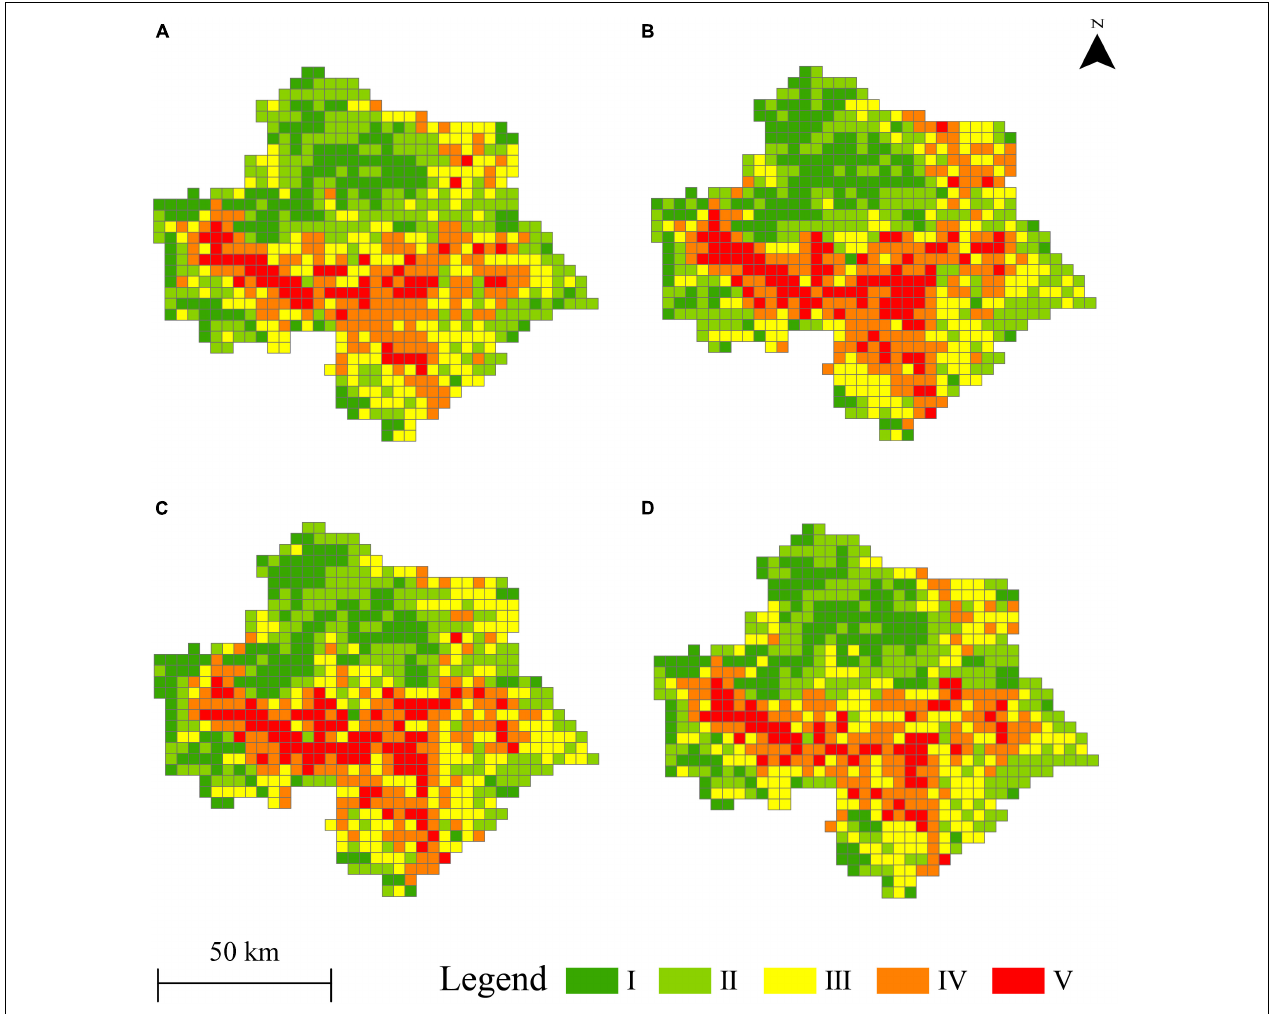
FIGURE 6 | Temporal and spatial distribution of ecological risk during the four periods in the Changshagongma Wetland Nature Reserve. (A) 1992, (B) 2002, (C) 2013, (D)